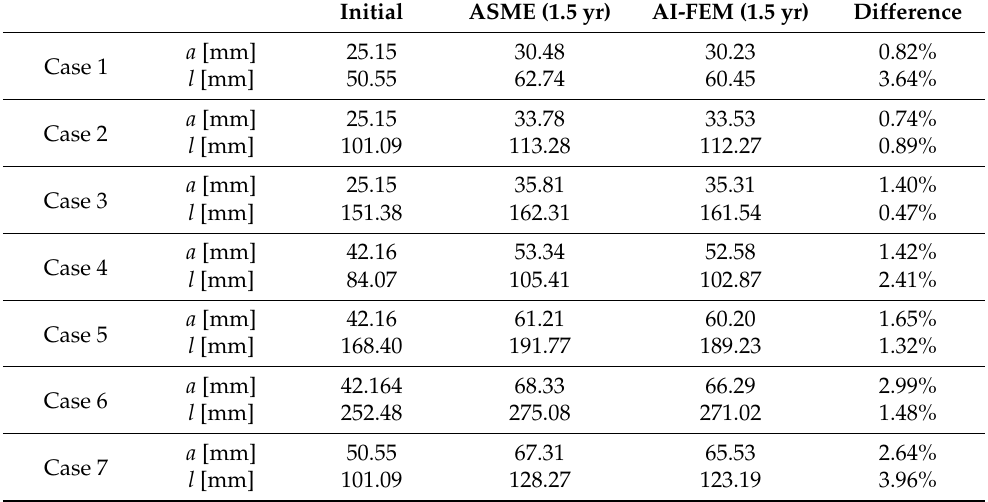
Table 7. Comparison of SCC growth